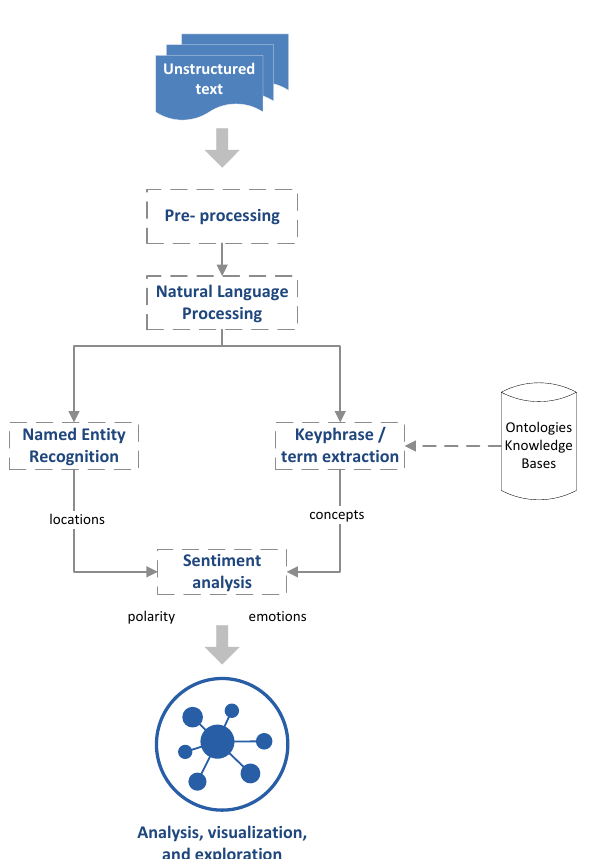
Figure 1 . Workflow of the proposed approach.